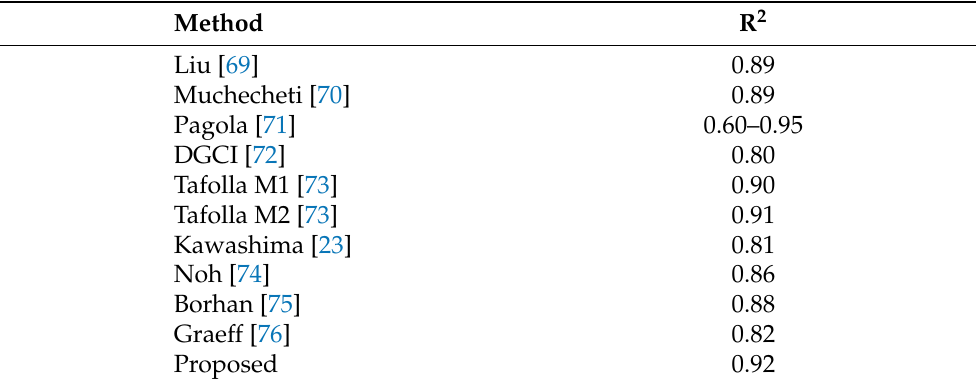
Table 4. Performance comparison of the proposed method with existing vision-based approaches for n-content estimation in plants.